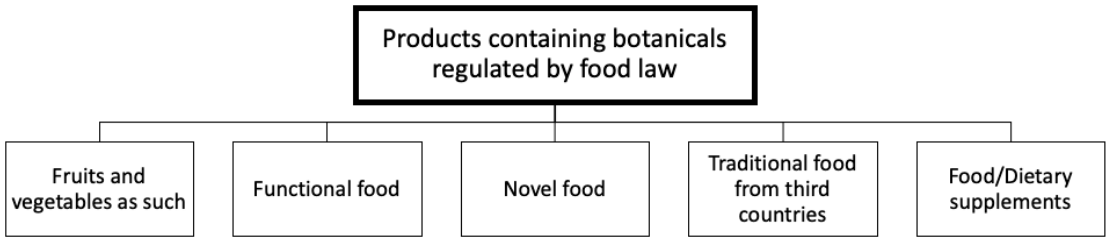
Figure 1. Categories of food containing botanicals.